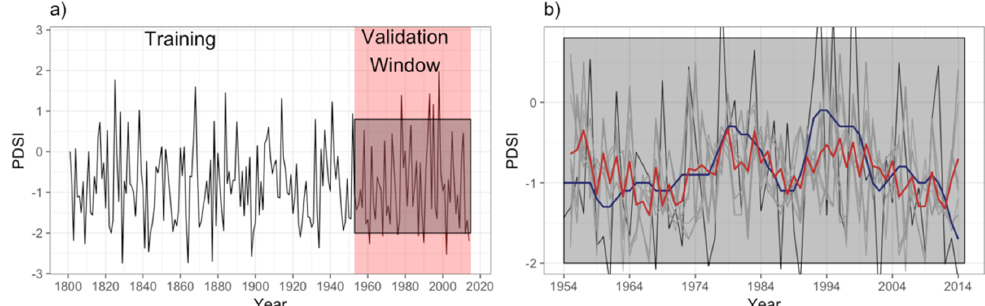
Figure 3. ( a ) Observed Palmer Drought Severity Index time-series (blue curve 1801–2014) with training and validation periods; ( b ) for the validation period, the simulated series (plume, light grey) with both the ensemble mean (red curve) and the observed Gaussian Filter with 11-year smoothing (bold grey curve).